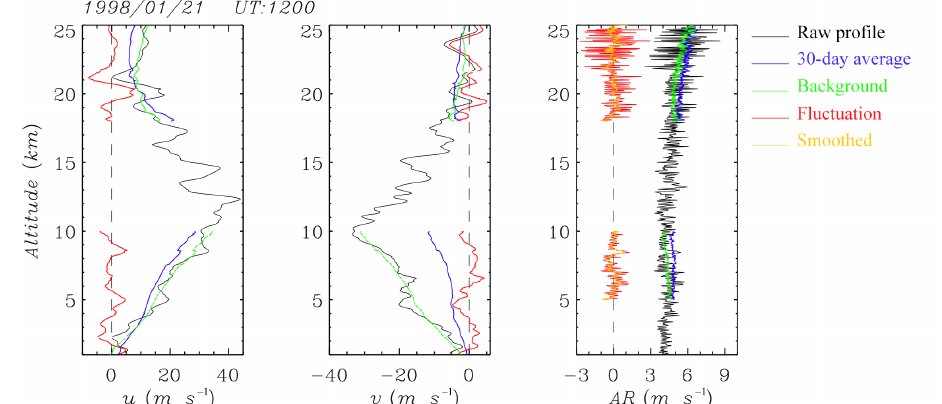
Figure 1. An example of the raw profiles and the extracted fluctuations on 21 January 1998. The left, middle, and right panels represent, respectively, the zonal and meridional winds and ascent rate profiles. The black curves denote the raw horizontal winds and ascent rate profiles. The blue and green curves denote, respectively, the 30-day averaged and total background components, i.e., the 30-day averaged components plus second-order polynomial fitted components. Red curves are the extracted wind fluctuations. The orange curves in the right panel are the smoothed vertical wind